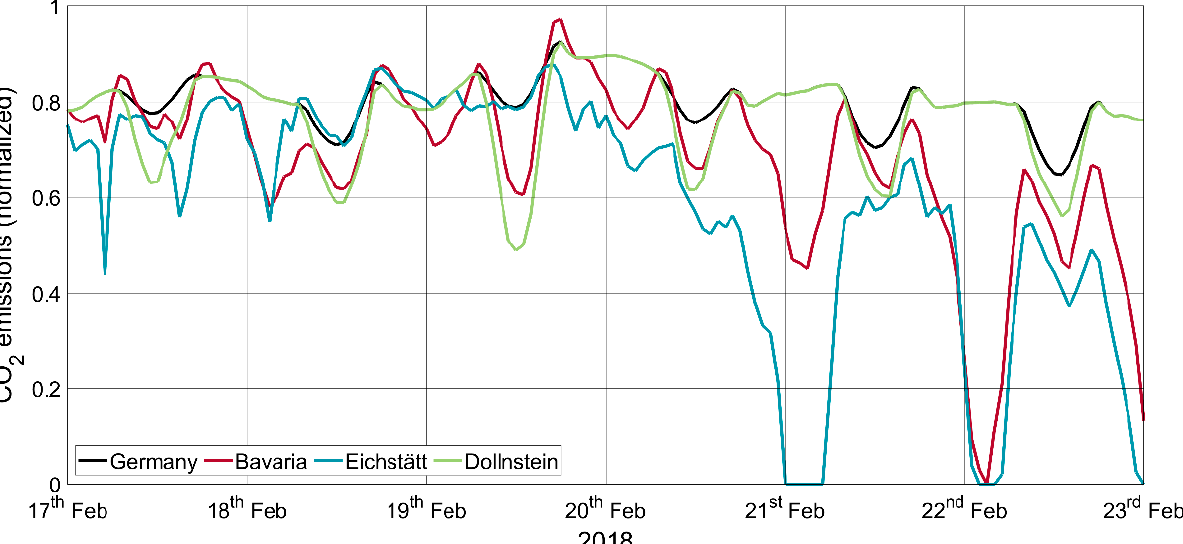
Figure 6. Comparison of the normalized CO 2 emission curves in Germany , and the German regions Bavaria , Eichstätt , and Dollnstein from 17th February until 22nd February.